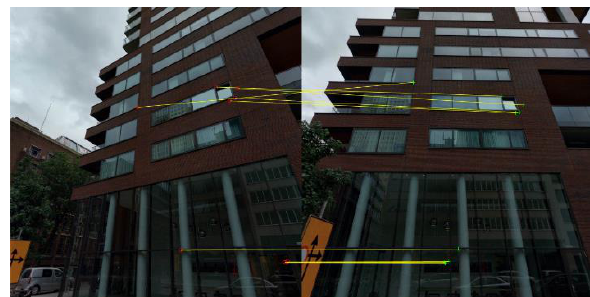
Figure 13. Mismatches due to repeated patterns on the same epipolar line